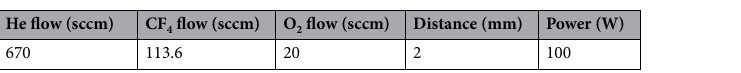
Figure 7. Typical removal profile by APPS.